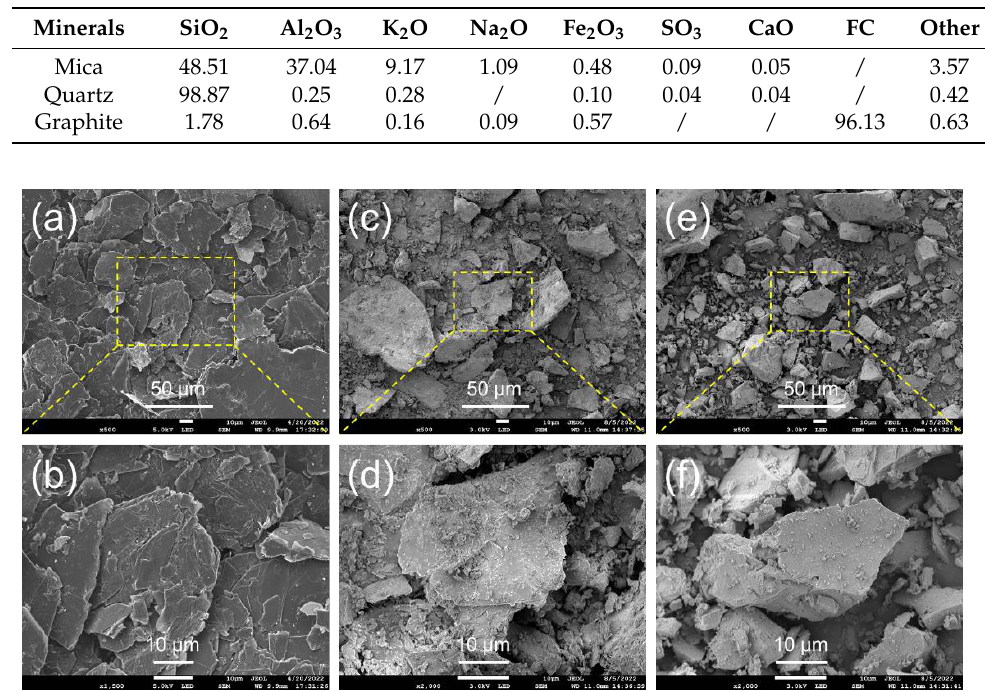
Table 1. Chemical composition of the test samples (wt %).